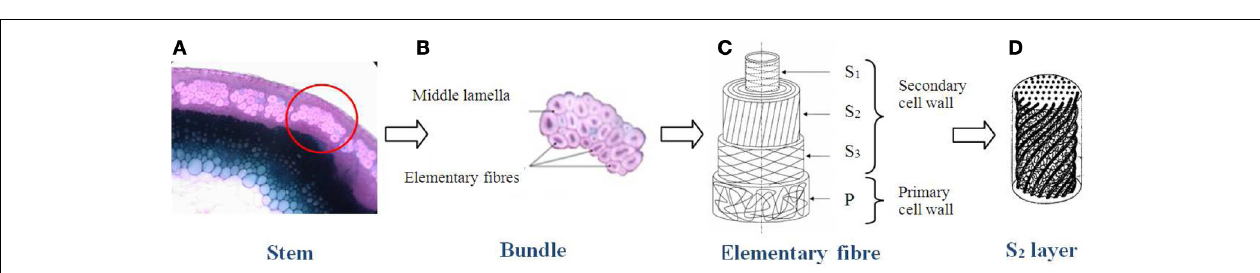
FIGURE 2 | Multi-scale structure of the flax fiber [Célino et al. (2013, 2014a,b) inspired by Baley (2002) and Morvan et al. (2003)]. (A) Stem of a flax plant, (B) bundle of flax fibres, (C) represntation of an elementary fibre, (D) the S2 layer of elementary